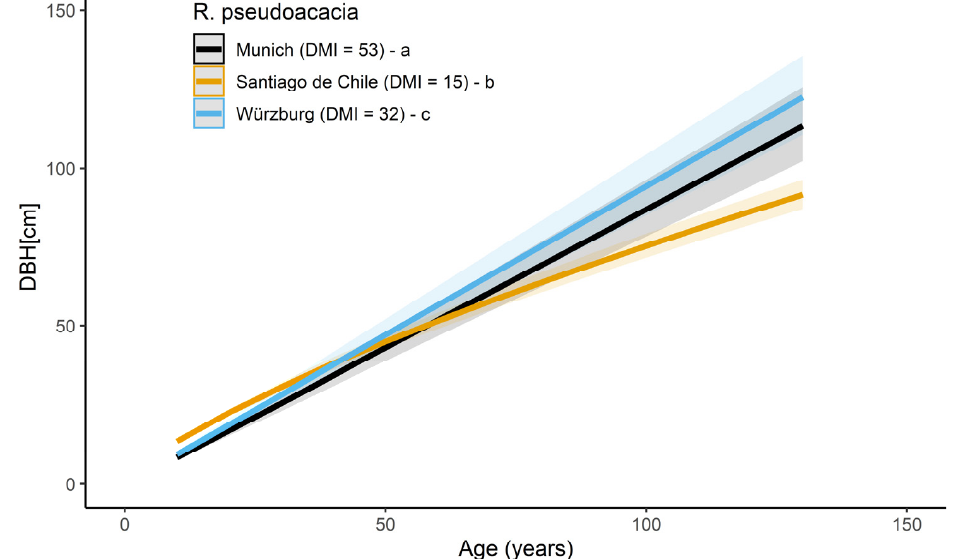
Figure 4. Stem diameter growth of R. pseudoacacia in Santiago de Chile (black curve, N = 129 trees), Munich (yellow curve, N = 30 trees), and Würzburg (blue curve, N = 31 trees). Letters a, b, and c show significant differences between the slopes. Shaded bands visualize the prediction confidence interval of the curves.